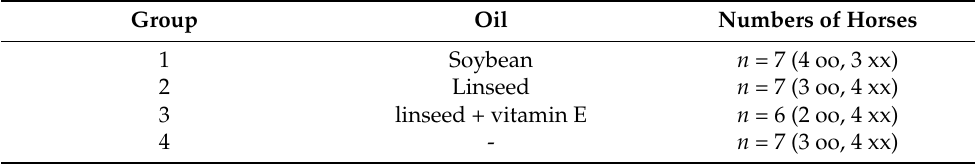
Table 1. The division into experimental groups. Group Oil Numbers of Horses 1 Soybean n = 7 (4 oo, 3 xx) 2 Linseed n = 7 (3 oo, 4 xx) 3 linseed + vitamin